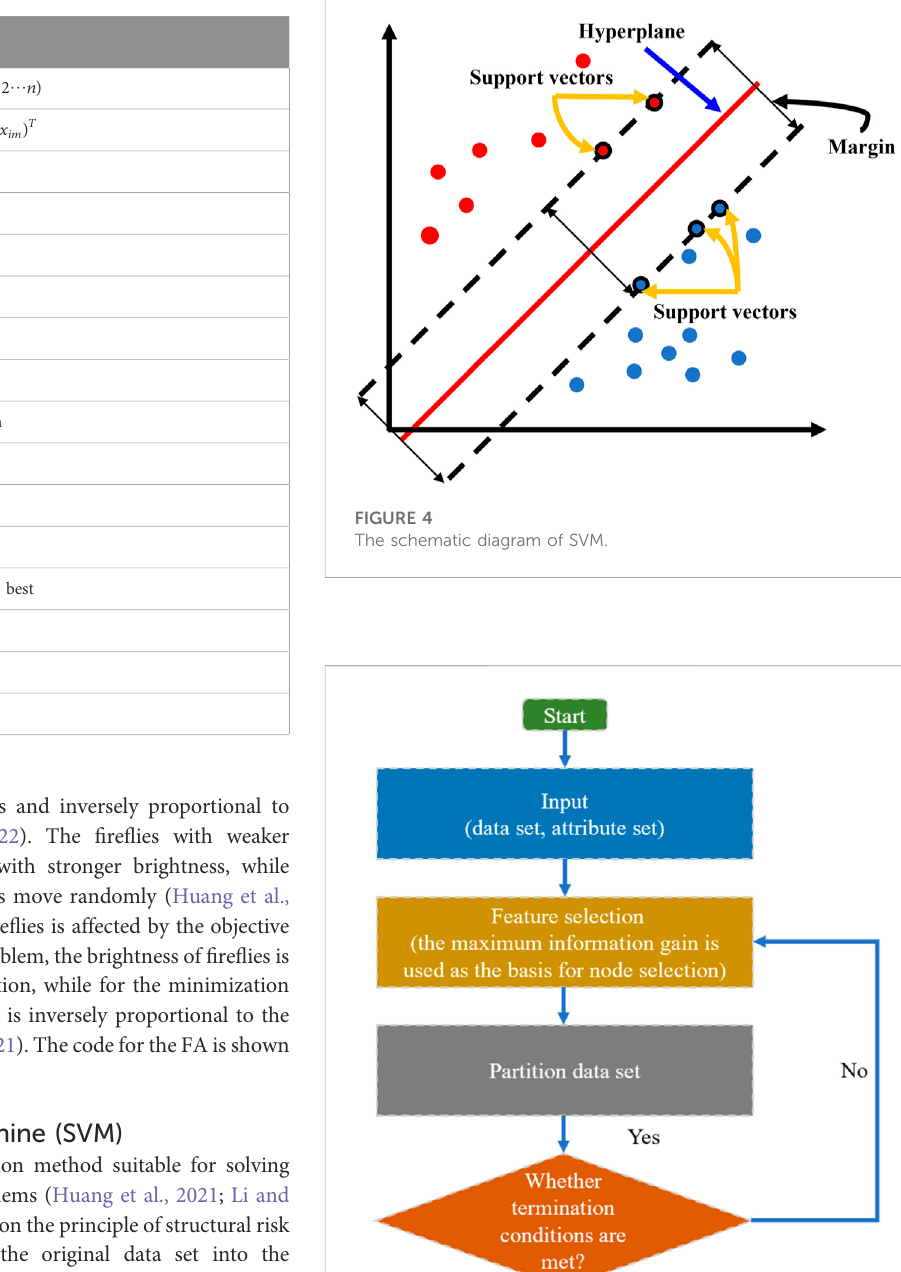
FIGURE 5 The fl ow chart of